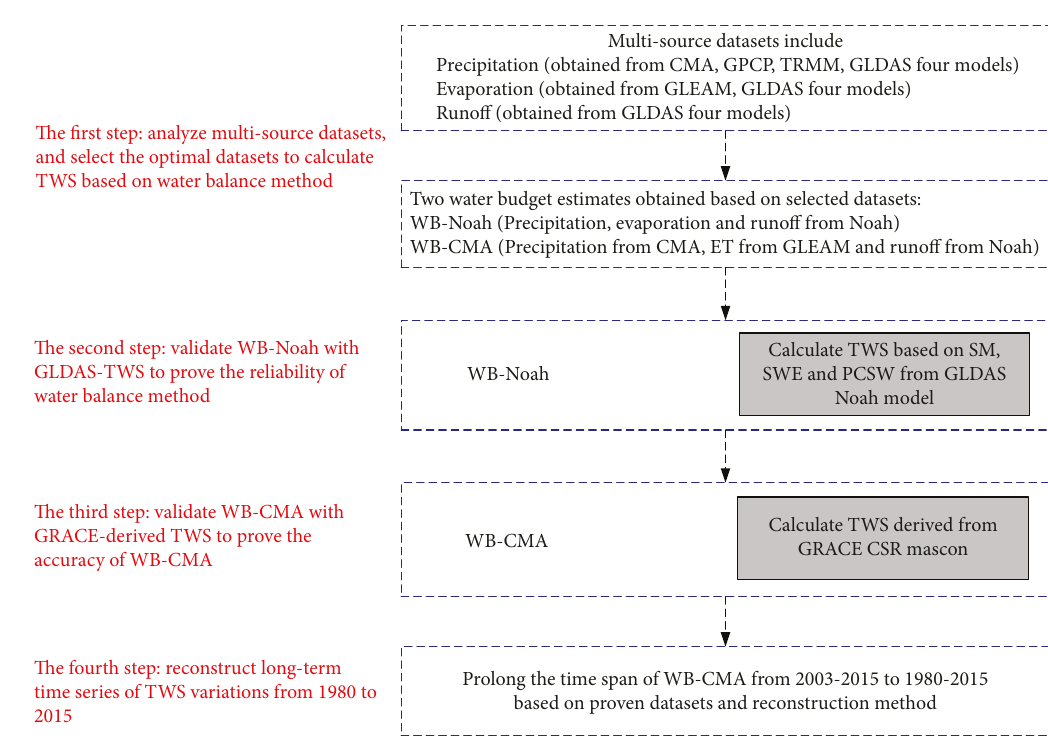
Figure 2: Work fl ow of the water balance method in this